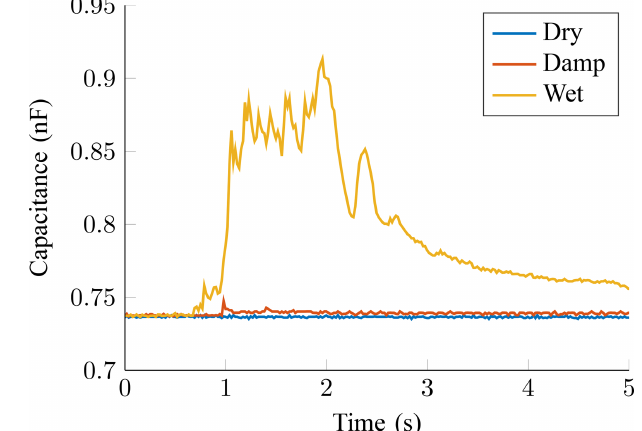
Figure 11. Field test results of capacitance against time for three different road surface conditions at 20kmh − 1 .